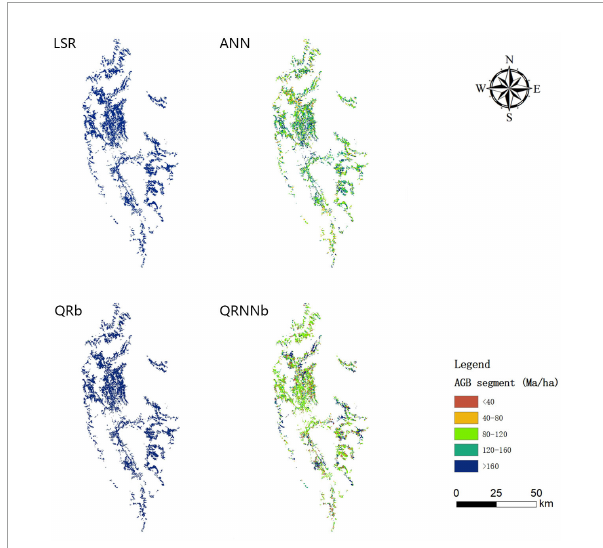
FIGURE6 The spatial distributions of the predicted aboveground biomass (AGB) values of the Pinus densata forests using four models (LSR, linear stepwise regression; ANN, artificial neural network; QRb, best quantile regression in each biomass segment; QRNNb, best quantile regression neural network in each biomass segment).